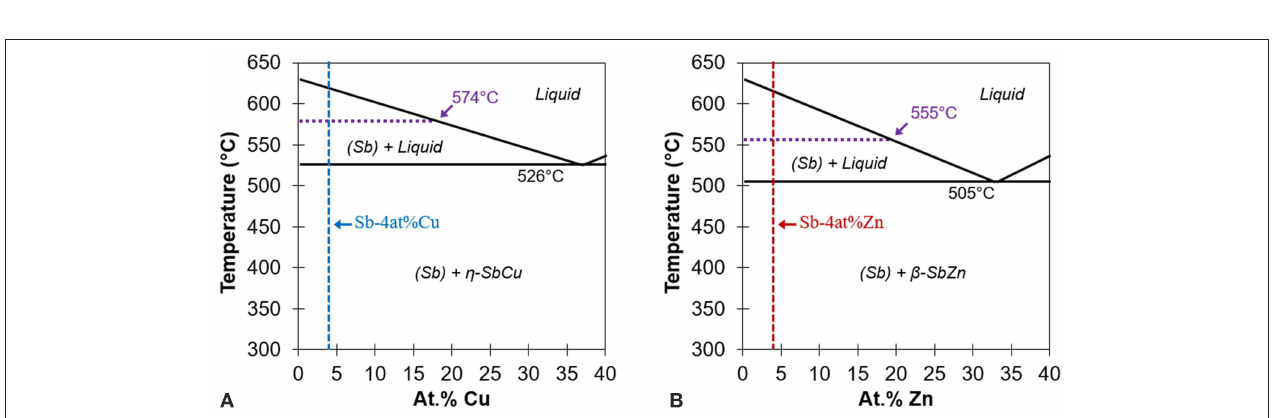
FIGURE 2 | Partial binary phase diagrams for (A) Sb-Cu and (B) Sb-Zn highlighting the high Sb region. Note the similarities between the two eutectic reactions. Adapted from ASM (2012).